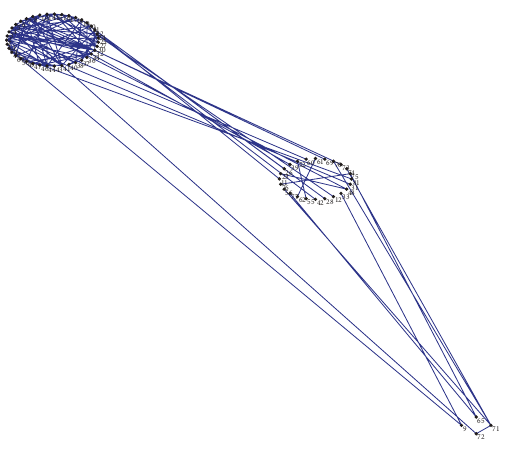
Figure 6: 3D picture of last